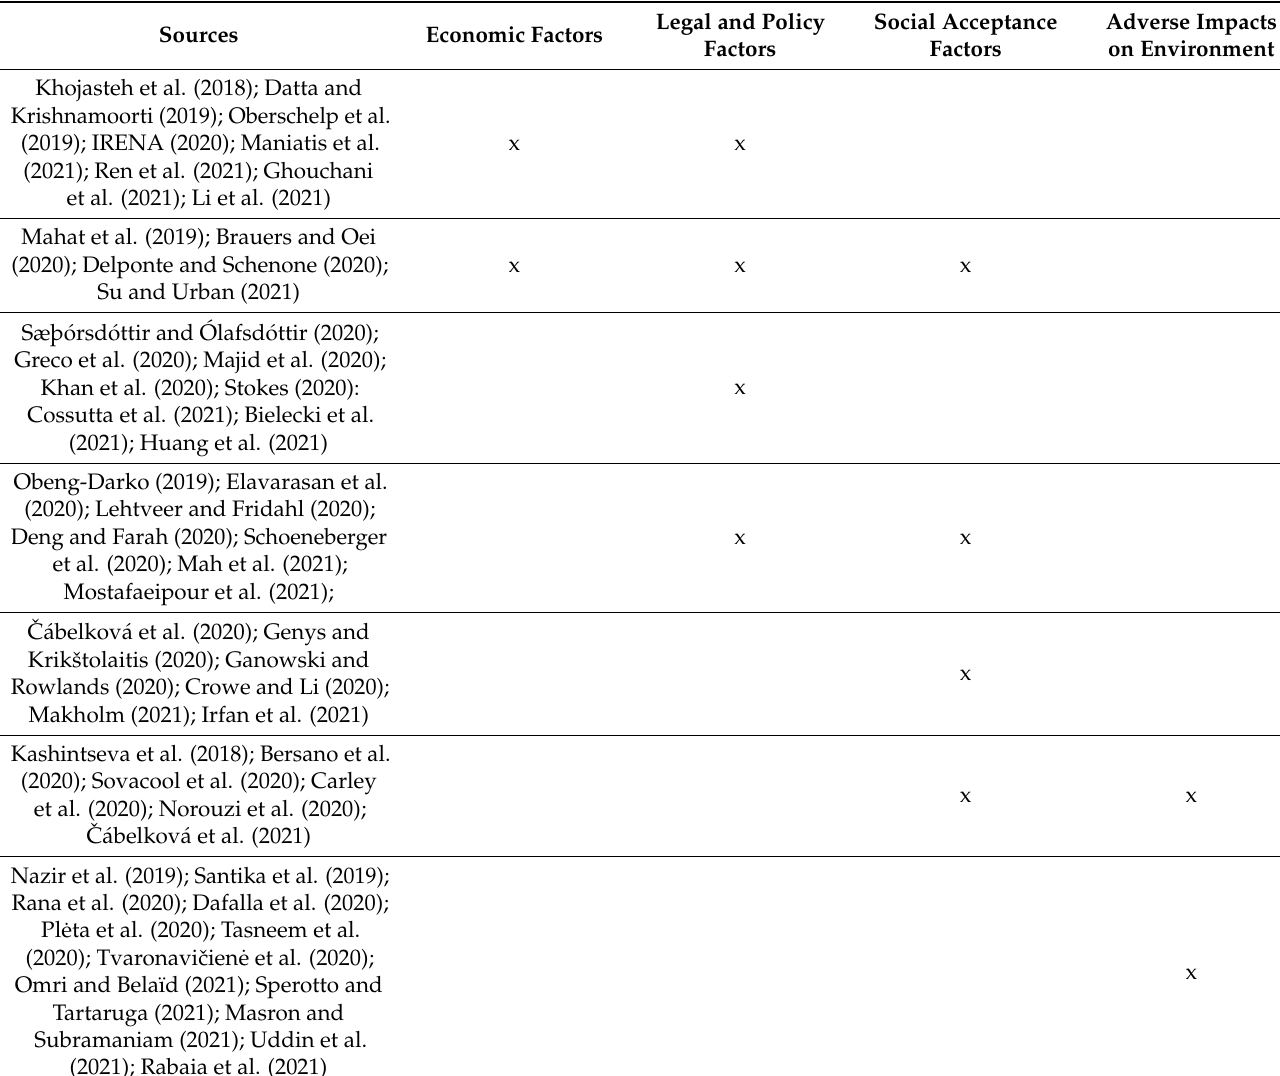
Table 1. Factors influencing the development of renewable energy in the electrical power sector. Sources Economic Factors